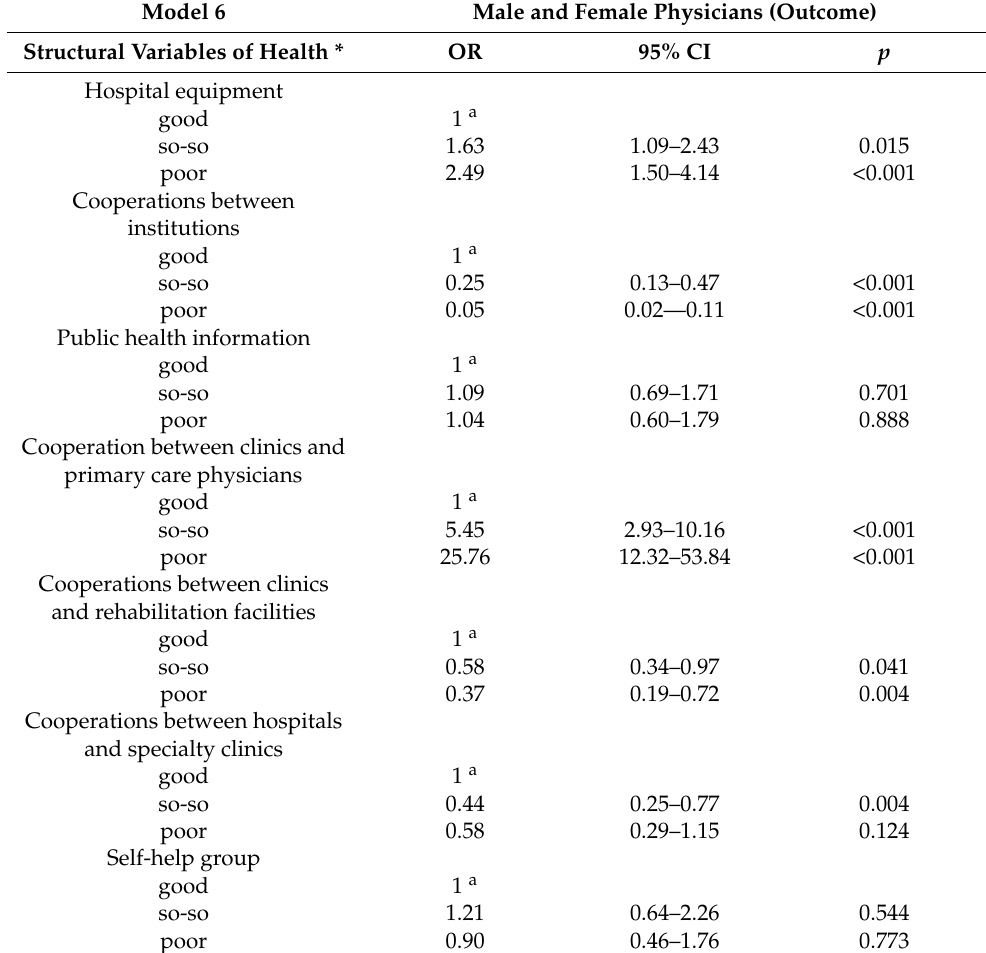
Table 4. Evaluation of the health care system in Salerno province by the male and female medical gender. Model 6 Male and Female Physicians (Outcome) Structural Variables of Health * OR 95% CI p Hospital equipment 1.63 1.09–2.43 0.015 2.49 1.50–4.14